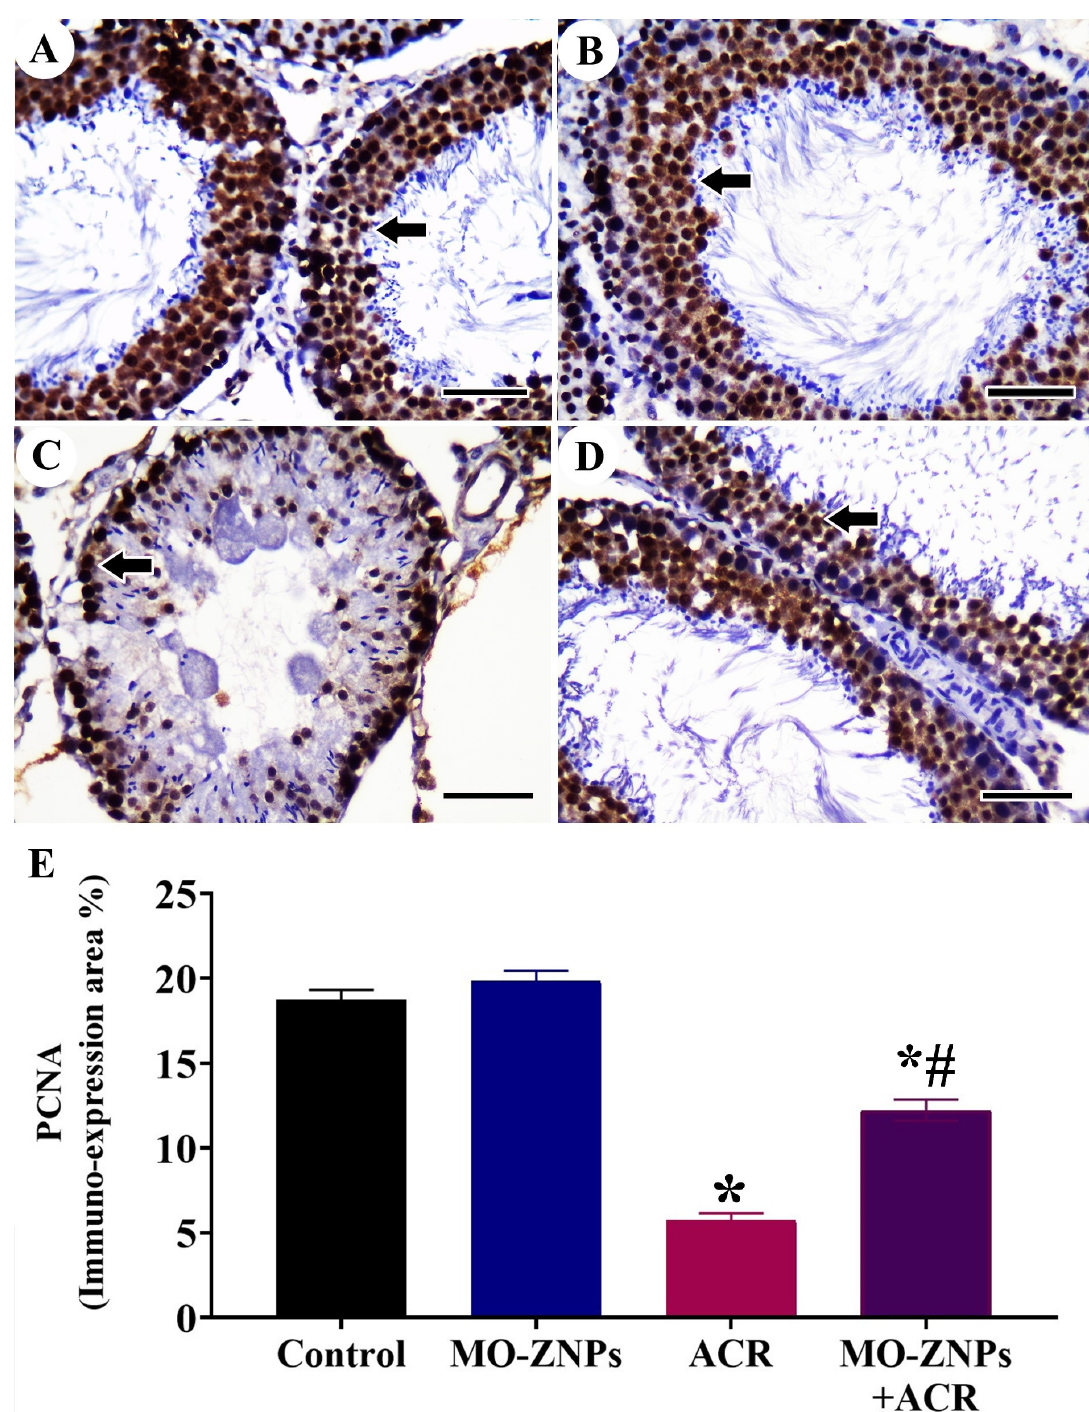
Figure 5. Immunohistochemical staining of rat testis by Proliferating Cell Nuclear Antigen (PCNA): ( A ) Control group and ( B ) MO-ZNPs group showing a high number of PCNA-reacted nuclei (arrows); ( C ) ACR group; ( D ) ACR+ MO-ZNPs group. Scale bar = 50 µm. ( E ). Changes in the immunohistochemical expression and quantitation of proliferating cell nuclear antigen (PCNA) in rat testis of the different experimental groups. Bars represent the mean ± SE. n = 10 replicates/treatment. * p < 0.05 vs. control. # p < 0.05 vs. ACR.